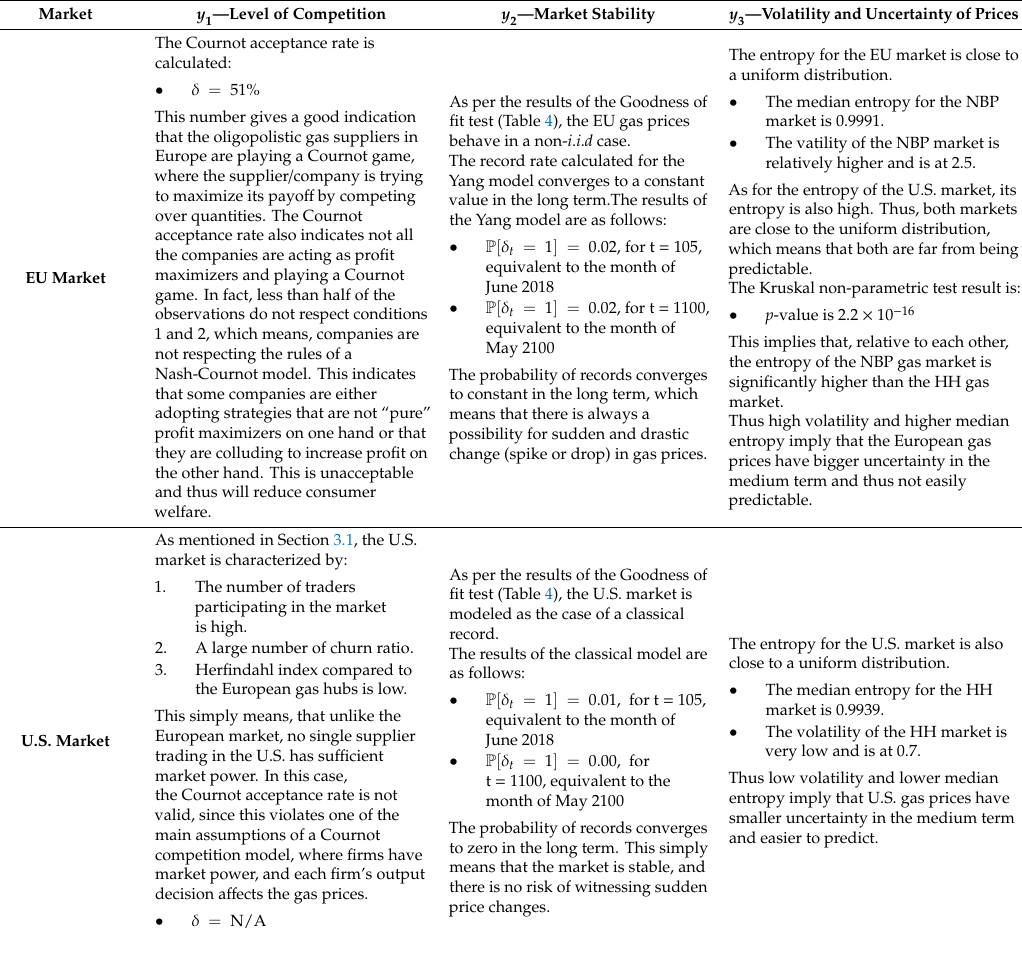
Table 8. Synthesis of indicator